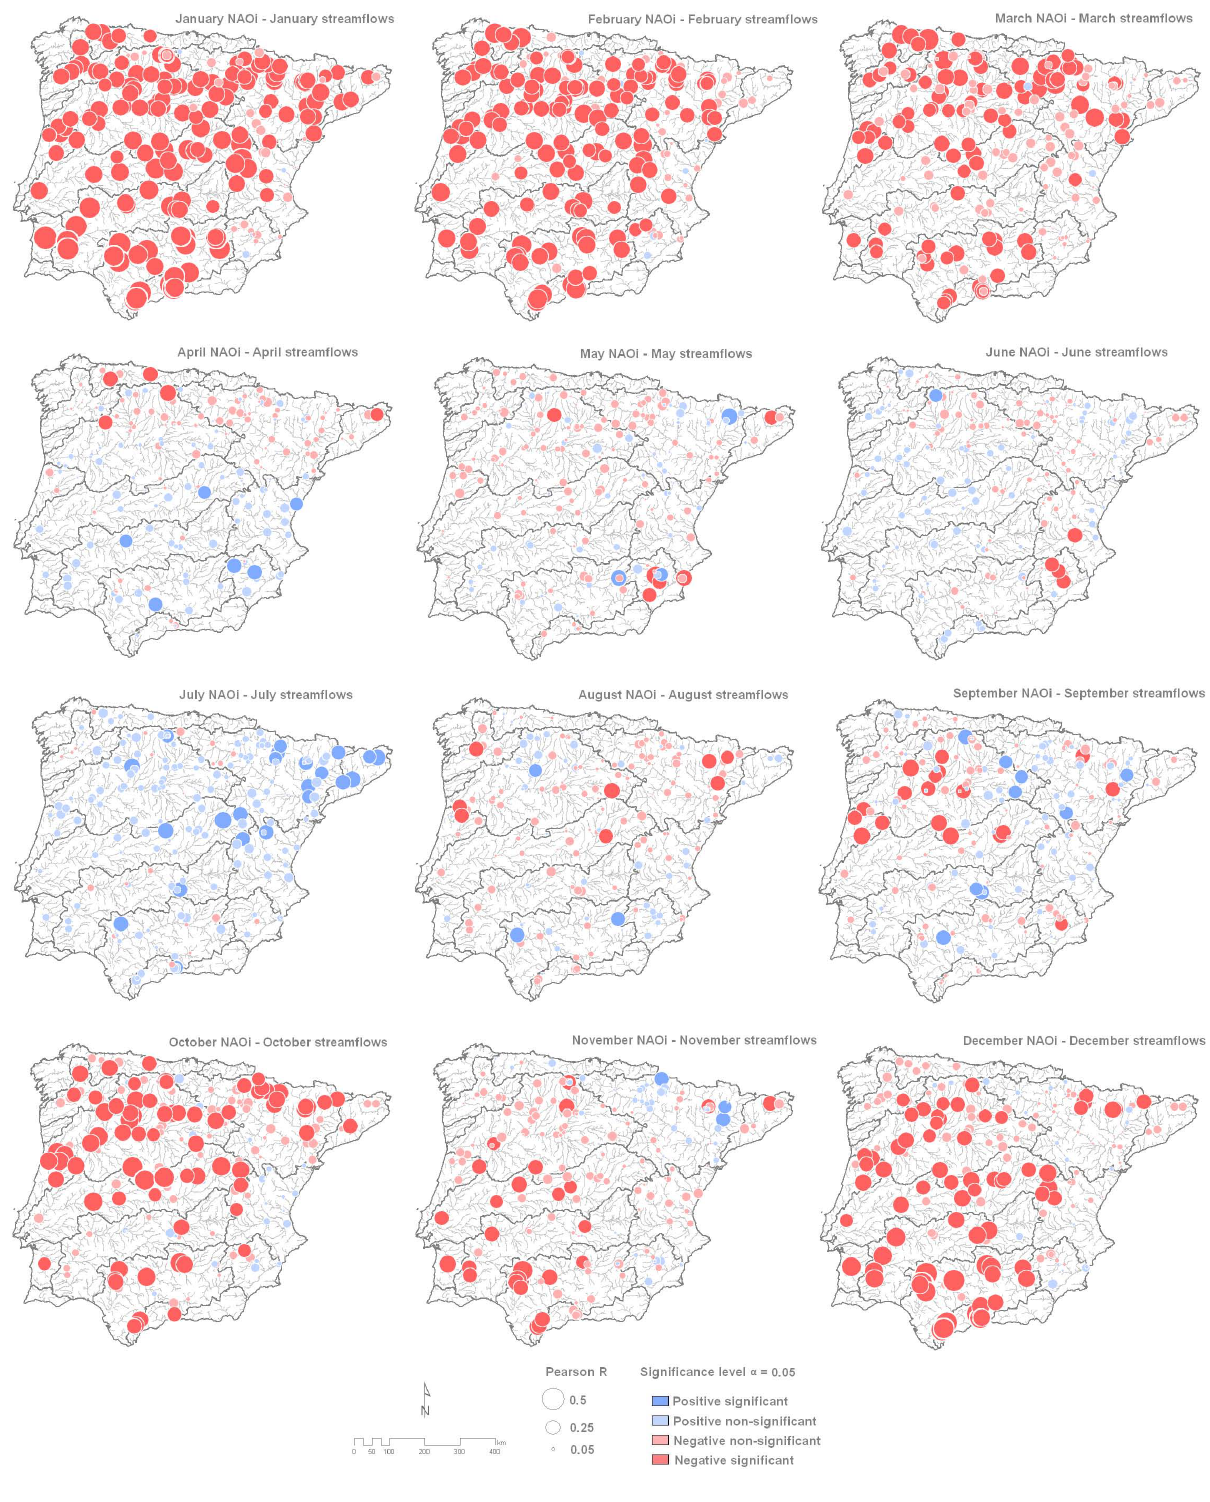
Fig. 2. Spatial distribution of the correlations between the monthly NAO index and the monthly SSI’s.